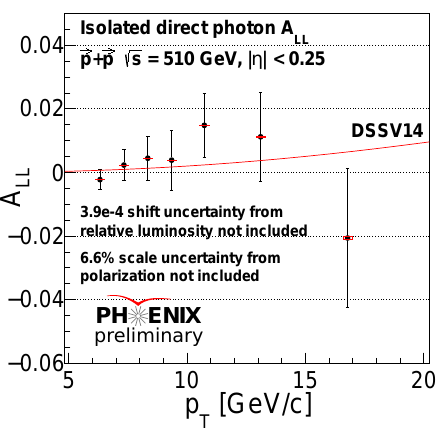
vs p for isolated direct photon production (cid:112) LL T s = 510 GeV at midrapidity. Vertical error bars (boxes)